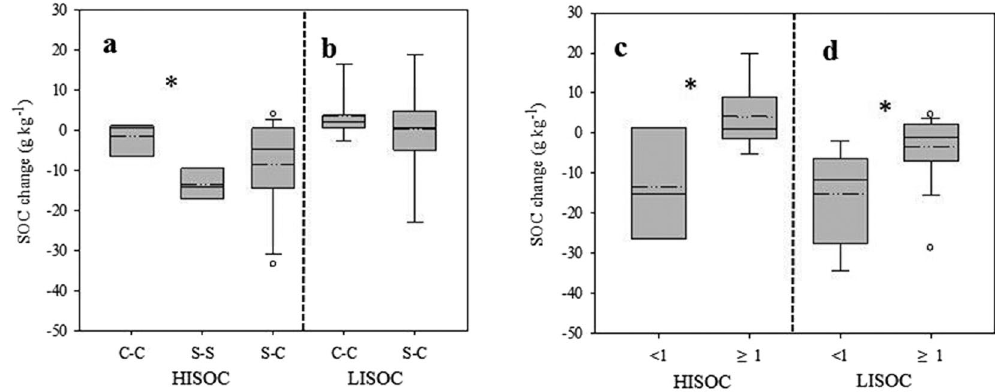
Figure 3. SOC change of cropping systems under different initial SOC. ( a ) SOC change of C-C, S-S, and S-C under HISOC (high initial SOC). ( b ) SOC change of C-C and S-C under LISOC (low initial SOC). ( c ) SOC change of S-C system under HISOC. ( d ) SOC change of S-C system under LISOC. < 1 means the duration of corn/soybean in the 10 year time span is less than 1. ≥ 1 means the duration of corn/soybean in the 10 year time span is equal to or greater than 1. Between each cropping system, means followed by asterisk are significantly different ( P < 0.05).